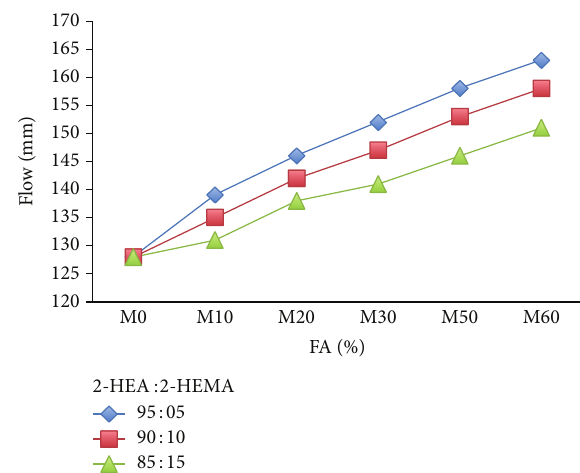
Figure 2: The effect of FA on the workability of mortar mixes in presence of latexes.